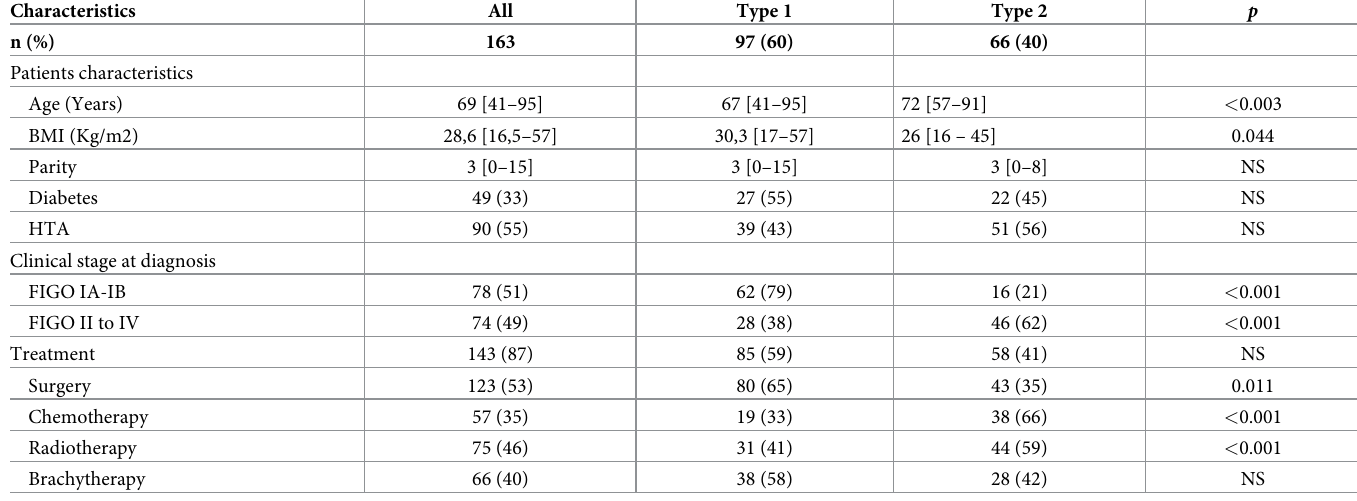
Median [minimum-maximum]; n (%).